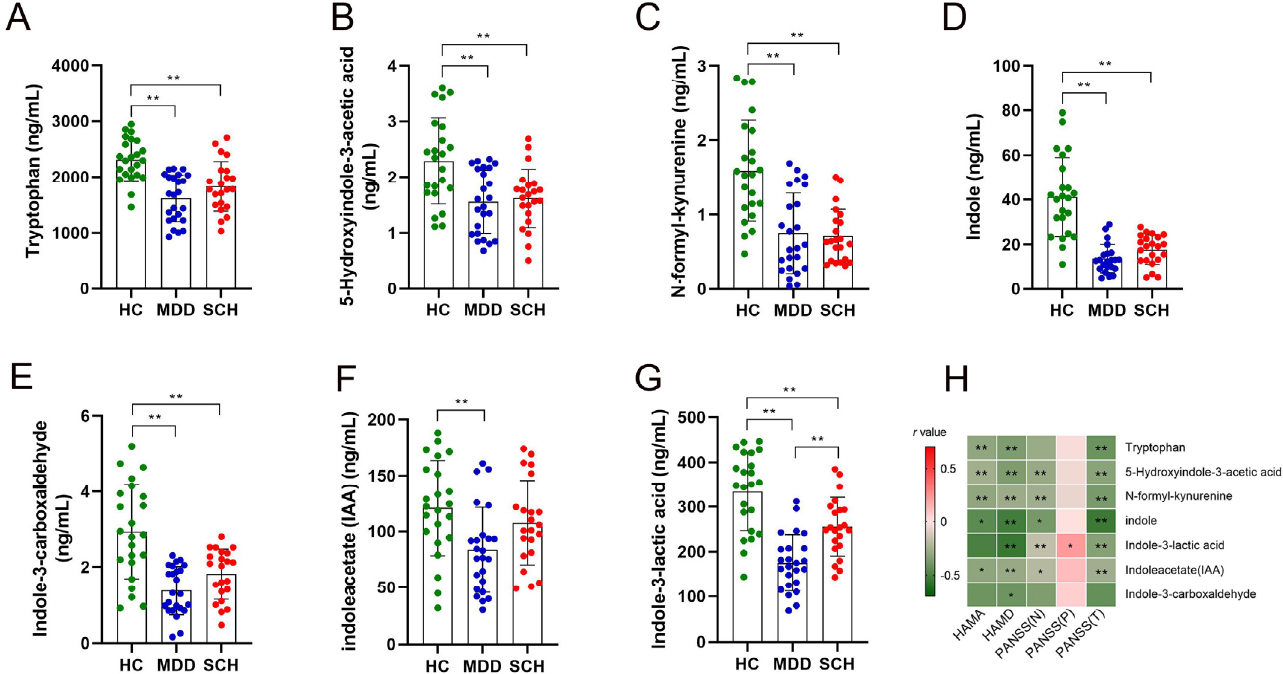
Figure 1. Comparison of concentrations of differential Trp metabolites among HC, MDD, and SCH participants. ( A ) Tryptophan, ( B ) 5-hydroxyindole-3-acetic acid, ( C ) N -formyl-kynurenine, ( D ) Indole, ( E ) Indole-3-carboxaldehyde, ( F ) Indoleacetate, ( G ) Indole-3-lactic acid, and ( H ) correlation between clinical parameters and changed metabolites. Red squares show a positive correlation and green squares show a negative correlation, * p < 0.05; ** p < 0.01. Table 2. Trp metabolites with no significant difference among the three groups.